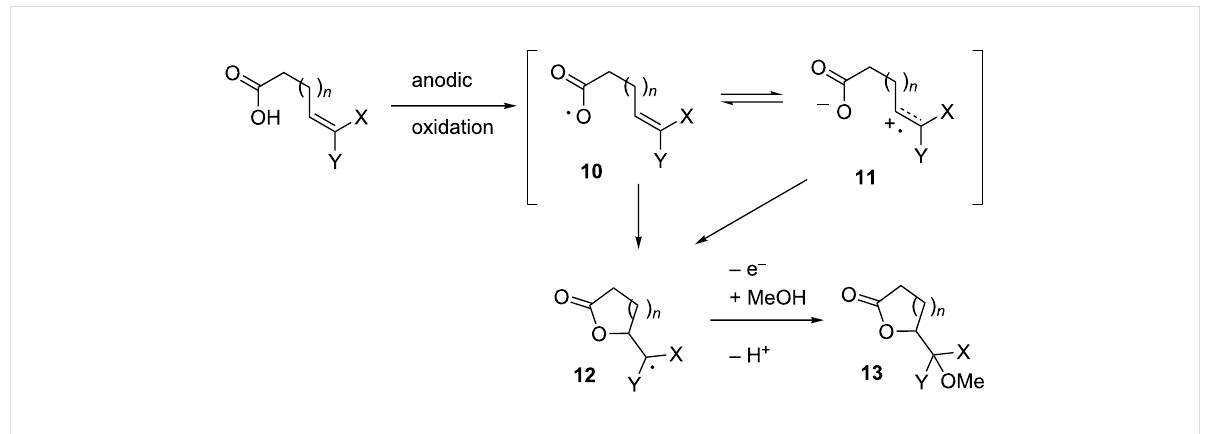
Scheme 4: Oxidative coupling between a carboxylic acid and electron-rich olefin.